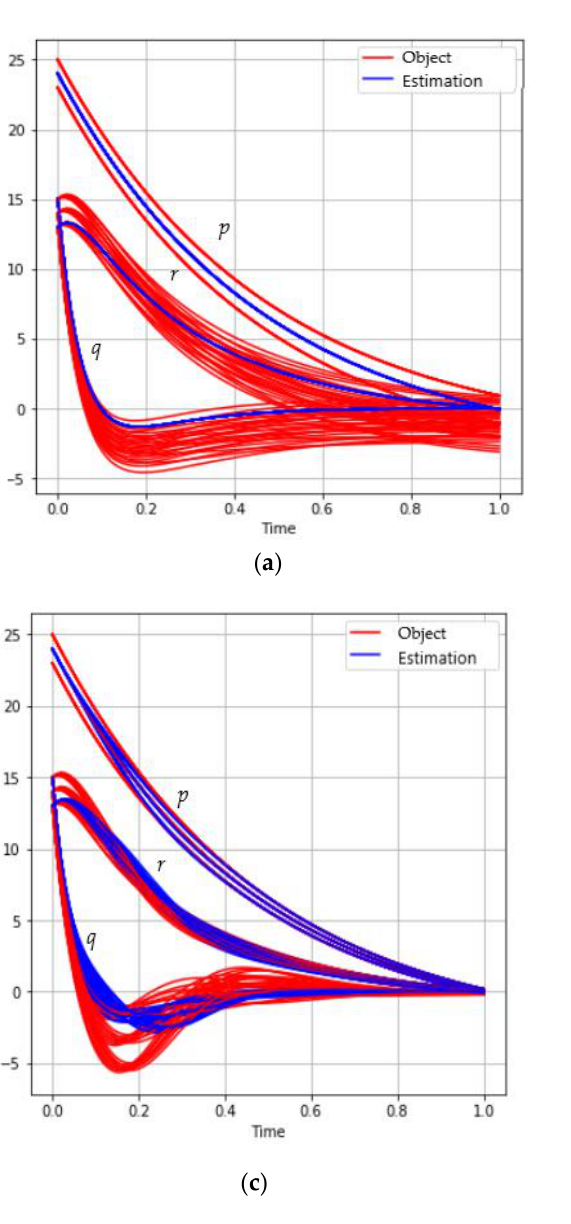
Table 1. Solution results for different mini-batch sizes.